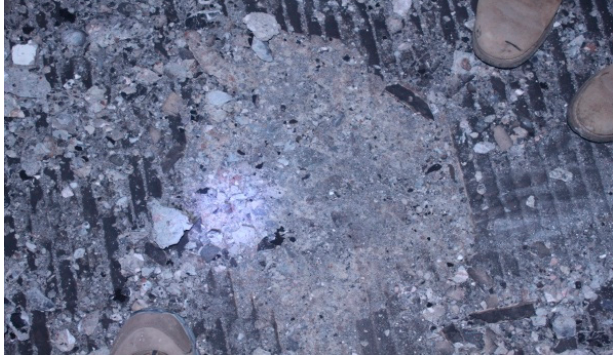
Figure 5. Ablation condition of surface concrete.